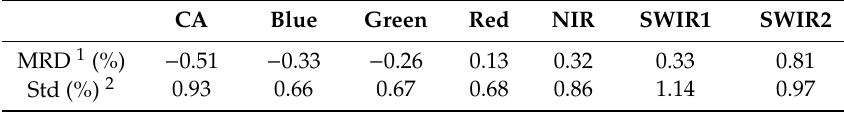
Table 6. Mean reflectance di ff erences for the combined ground truth sites. CA Blue Green Red NIR SWIR1 SWIR2 MRD 1 (%) − 0.51 − 0.33 − 0.26 0.13 0.32 0.33 0.81 Std (%) 2 0.93 0.66 0.67 0.68 0.86 1.14